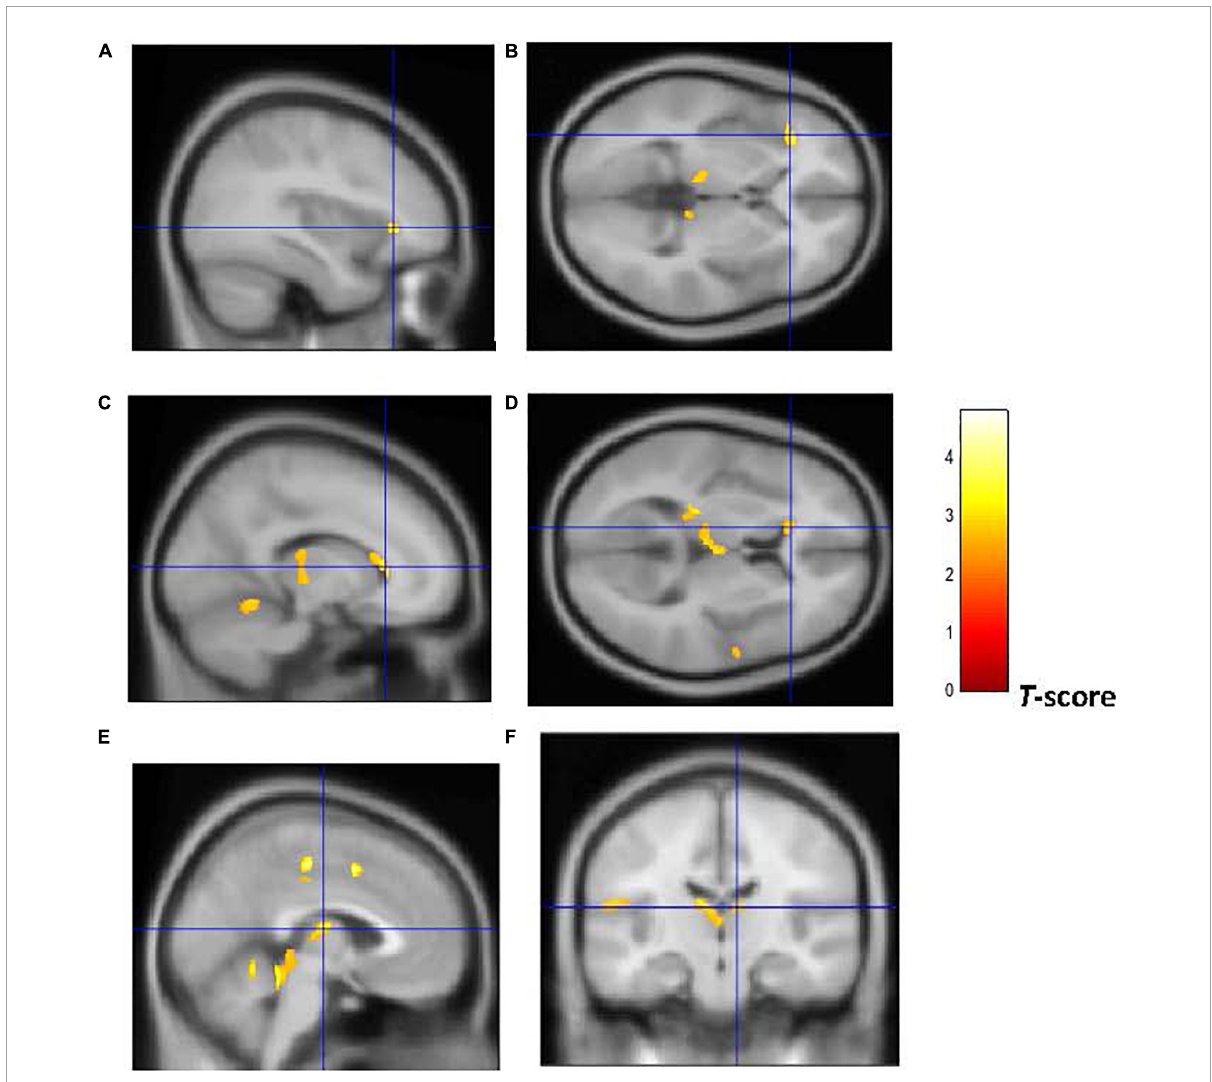
FIGURE3 Brain regions of interest displaying lower WM volume in early onset smokers in comparison to non-smokers. The figure shows early onset smokers to display lower WM volume in the left AI [region of interest centered at –36, 30, 0 MNI coordinates in sagittal (A) and axial (B) planes]; left anterior corpus callosum [region of interest centered at –14, 27, 28 MNI coordinates in sagittal (C) and axial (D) planes]; and bilateral thalamus [region of interest centered at –3, –14, 12 MNI coordinates in sagittal (E) plane, and at 9, –18, 14 MNI coordinates in coronal plane (F) ] in comparison to non-smokers. The cluster forming threshold consisted in p < 0.01 with a minimum of 100 contiguous voxels per cluster at a whole-brain corrected level. TIV, age, and biological sex were inserted as covariates of no